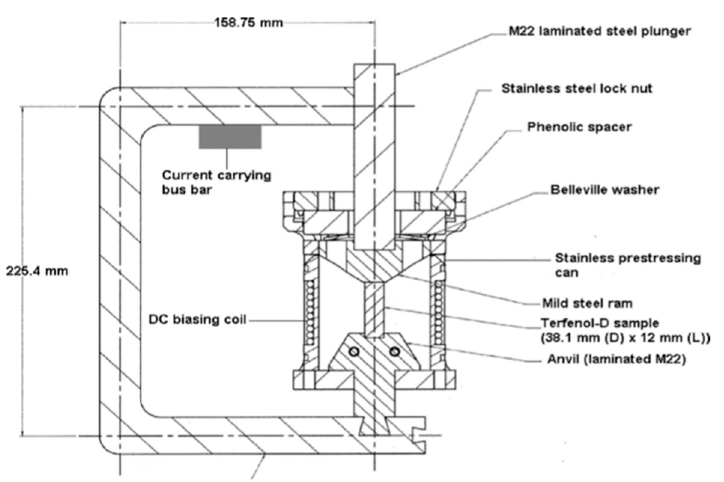
Figure 7. Optical fiber current sensor based on 40 g cylindrical rod magnetostrictive material.